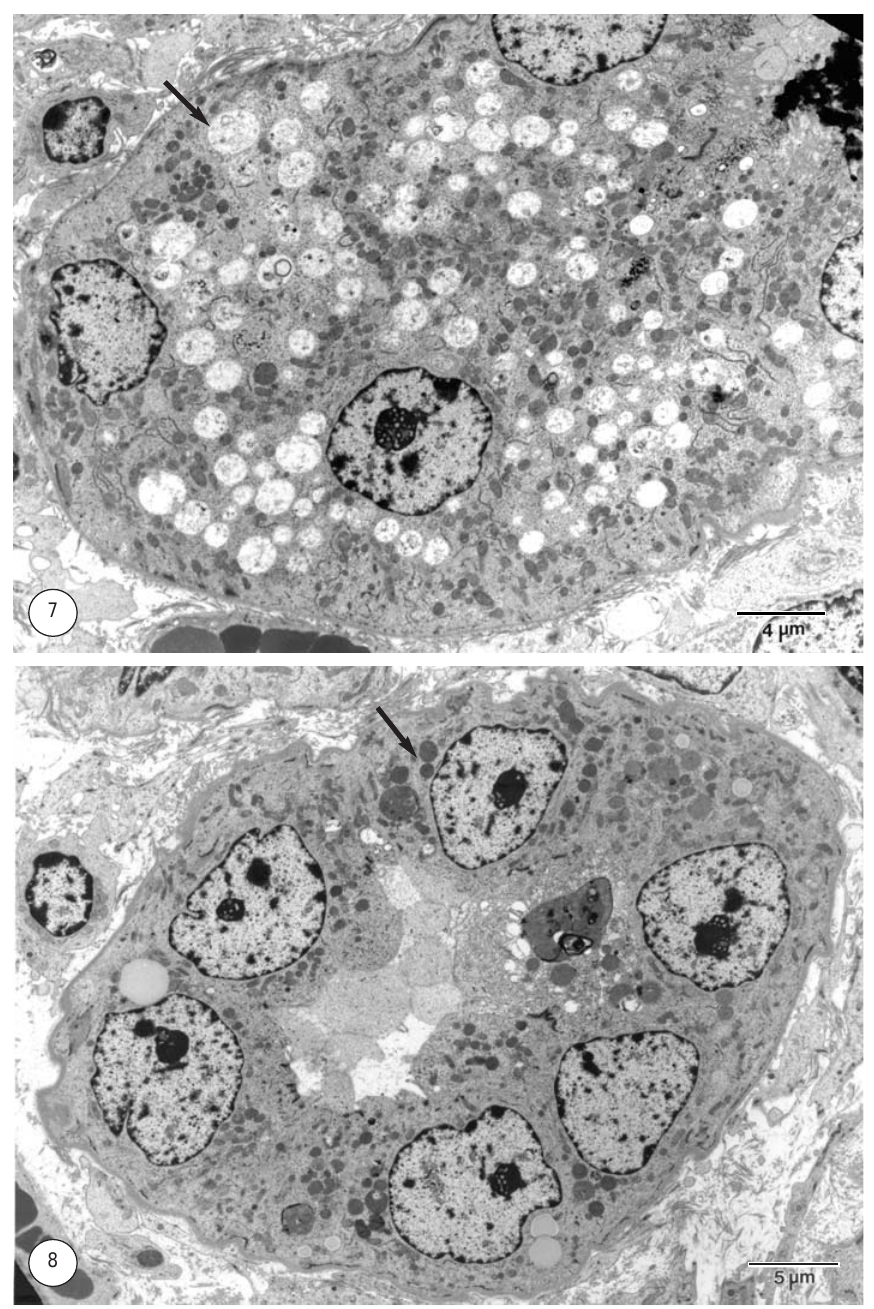
FIG. 7 Proximal convoluted tubule epithelial cell. Note the swollen mitochondria with loss of internal structure ( (cid:133) ). Parallel orientation of mitochondria to the cell axis is lost FIG. 8 Proximal convoluted tubule epithelial cell. Note the increase in intracellular electron- dense bodies interpreted as primary lysosomes (